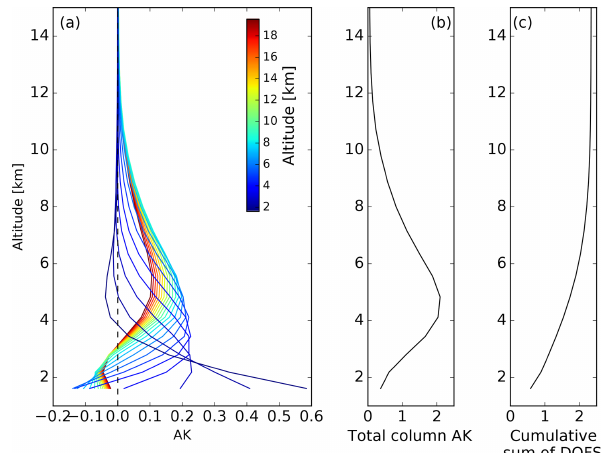
Figure 2. (a) FTIR mean row averaging kernels, (b) mean total col- umn averaging kernel, and (c) cumulative sum of DOF of WV ob- tained in BLD from 2010 to